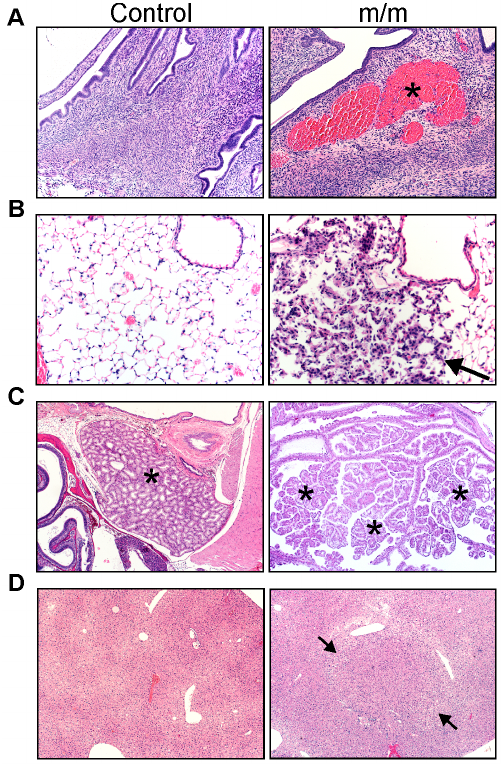
Figure 4. NIAM m/m mice are predisposed to proliferative lesions. Histopathologic analyses of multiple mouse tissues. A . A hemangioma (asterisk, right panel) found in the uterus of a NIAM m/m mouse compared to normal uterine tissue (left panel). (H&E, 100x) B . Pulmonary papillary adenoma in a homozygous NIAM m/m mouse (arrow, right panel). A depiction of normal lung tissue from a control mouse is shown (left panel). (H&E, 20x) C . Harderian gland adenoma of a NIAM m/m mouse (asterisks, right panel). A representative image of a normal Harderian gland (asterisk) from a control mouse is depicted (left panel). (H&E, 40x) D . A representative image of a normal liver from a control mouse (left panel) versus a focus of cellular alteration (arrows) in a NIAM m/m mouse (right panel). (H&E, 40x) Controls represent tissues from similarly aged wild-type (panels B and C) and NIAM + /m heterozygous (panels A and D) mice, which were found to be indistinguishable in our analyses.